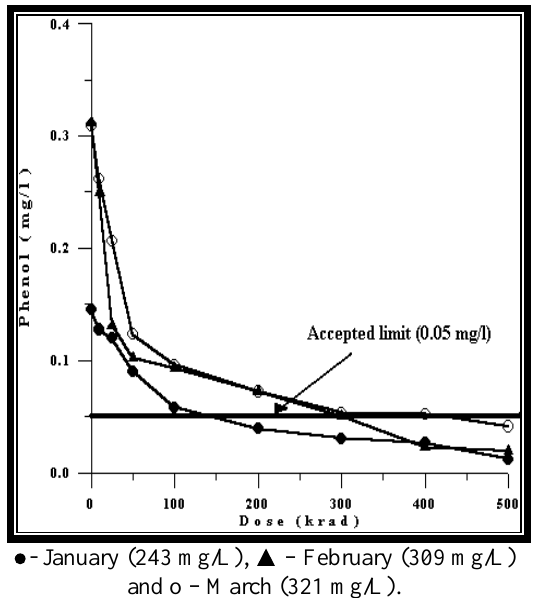
Figure 11: Phenol concentration of irradiated sample of wastewater for